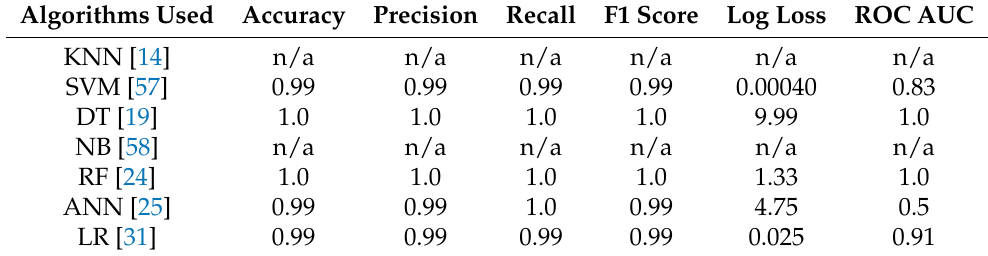
Table 17. DDoS TCP weighted classes results.